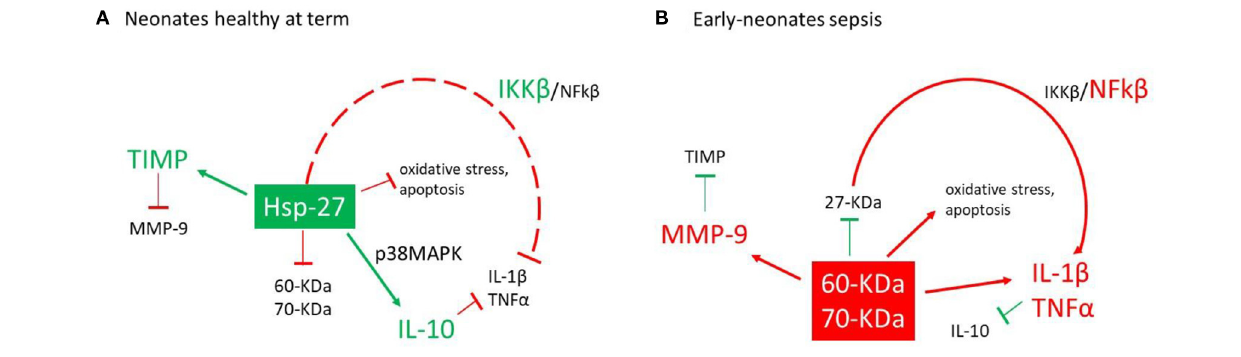
FIGURE 3 | Action model for the activation of e Hsp and proinflammatory cytokines. (A) In healthy neonates at term, e Hsp-27 modulates the expression of the protein inhibitor (Ik β ) reducing the activity of the nuclear factor-kappa β (NFk β ) pathway ( 17, 31), modulating the inflammatory response (17, 47), oxidative stress (39), and action of matrix metalloproteinases-9 (MMP-9) ( 49, 52). (B) During the infections process, the inflammatory response is activated which reduces the expression of e Hsp-27, increased the expression of e Hsp-60, e Hsp-70, and NFk β and finally increases the secretion of IL-1 β , TNF α , and MMP-9 (48, 51,